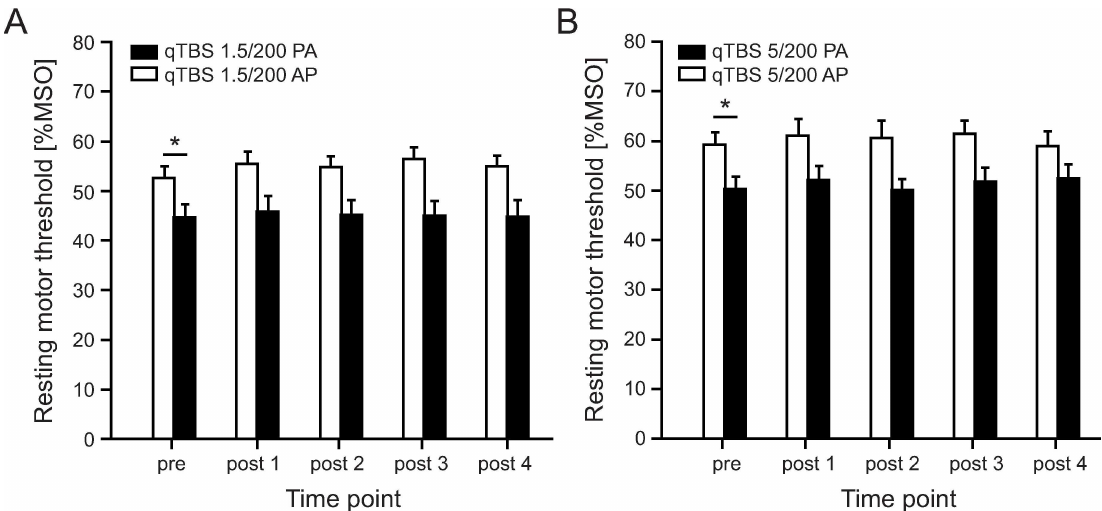
Fig 4. Motor threshold following qTBS in AP and PA direction in qTBS at 1.5 ms (A) and 5 ms (B) interstimulus intervals. No significantchangesin rMT were observedafter qTBS. MT in AP and PA directionsignificantly differed at pre measurements as expected. qTBS: quadri-pulse theta burst stimulation;PA: posterior-anterior; AP: anterior-posterior.